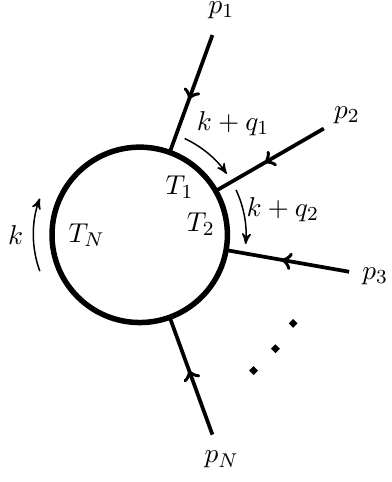
Figure 1 . One-loop n -point diagram, with the loop momenta and proper-time